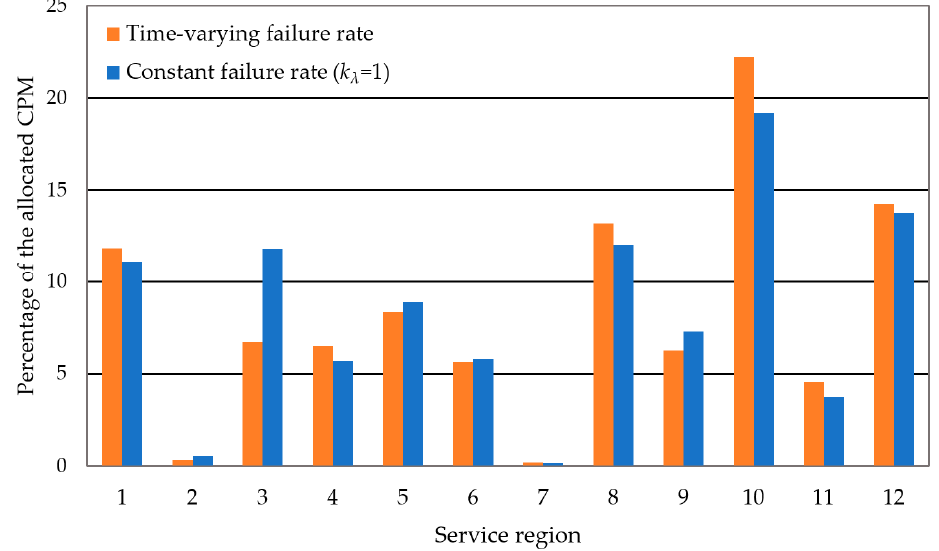
Figure 7. The percentage of allocated preventive maintenance budget by service region.